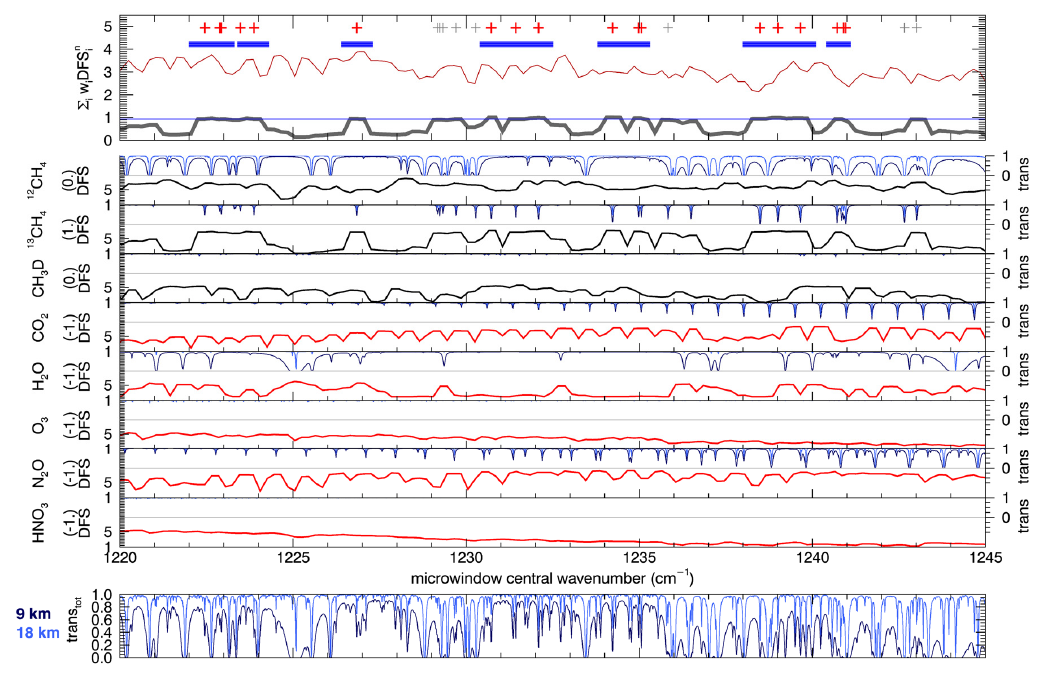
Figure 6. Excerpt of the output data generated for TIR spectral channel optimization. Top panel shows the weighted sum of the normalized DFS traces for products (black) and interfering species (red). Regions where the total product DFS exceeds a threshold (thin blue line) are shown as thick blue segments on top. Sub-selected 13 CH 4 line positions are shown as grey + signs (shown in red if also intersecting high product DFS regions). The following plots give individual DFS traces for products (black, weights in parentheses) and interfering species (red), as well as the atmospheric transmission at 9 (dark blue) and 18 (light blue) km computed for these species separately. Total limb transmission is in the last plot.